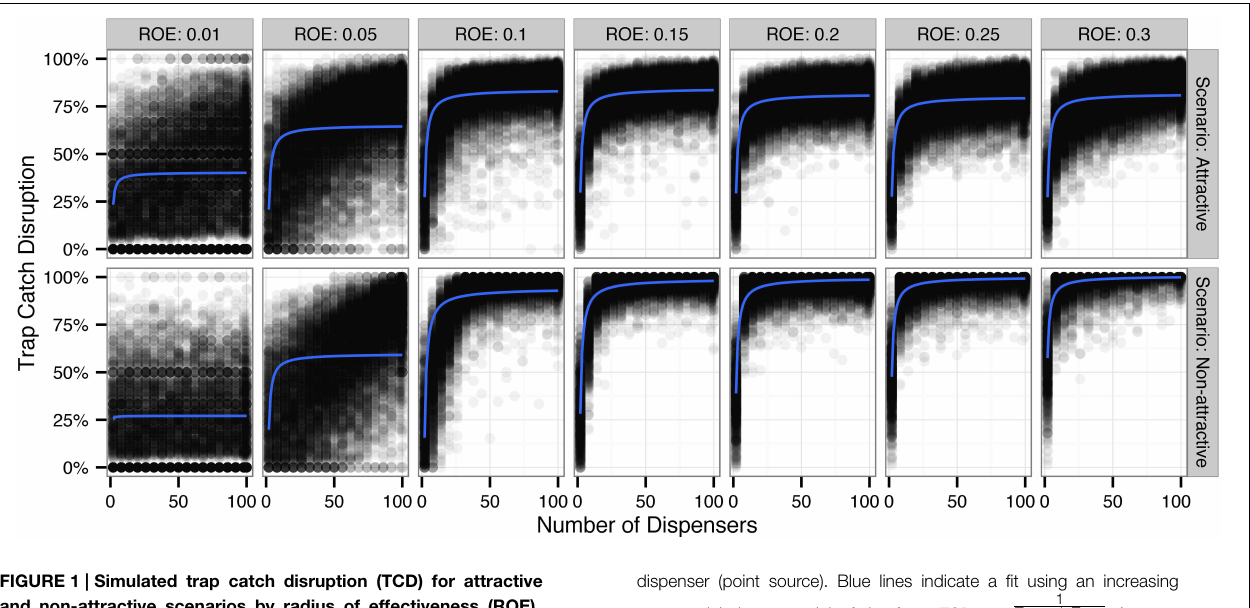
1 Treated Trees (see